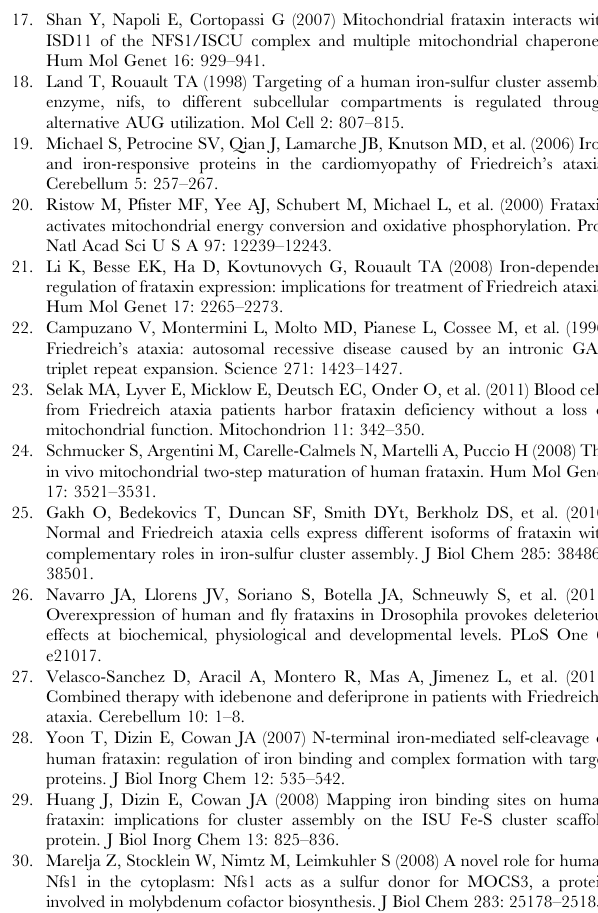
Figure S1 Subcellular localization of human FXN iso- forms. C-terminal myc-tagged FXN isoforms were expressed in HEK293 cells. The localization was determined by Confocal. (TIF) Figure S2 Two-component (ISCU + ISCS, panel 1,3) or three-component(ISCU + ISCS/ISD11, panel 4)complexes were detected in a single NI-NTA affinity purification step. His-tagged human ISCU was over-expressed and purified with NI-NTA resin. Endogenous IscS of E. coli (panel 1, 4) and untagged recombinant human ISCS with (panel 4) or without ISD11 (panel 3) could be co-purified with human ISCU, confirmed by mass spectrometry. BL21(DE3): E. coli strain for over-expression of recombinant protein; CL100(DE3): E. coli strain with iscS deletion ( D isc S). (TIF)